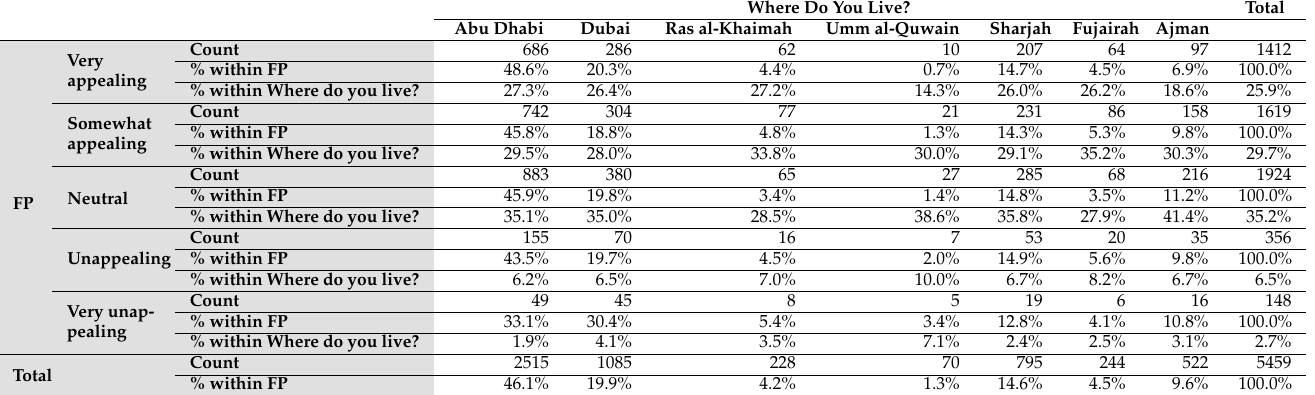
Table 22. Functional private value for EVs and respondents’ emirates